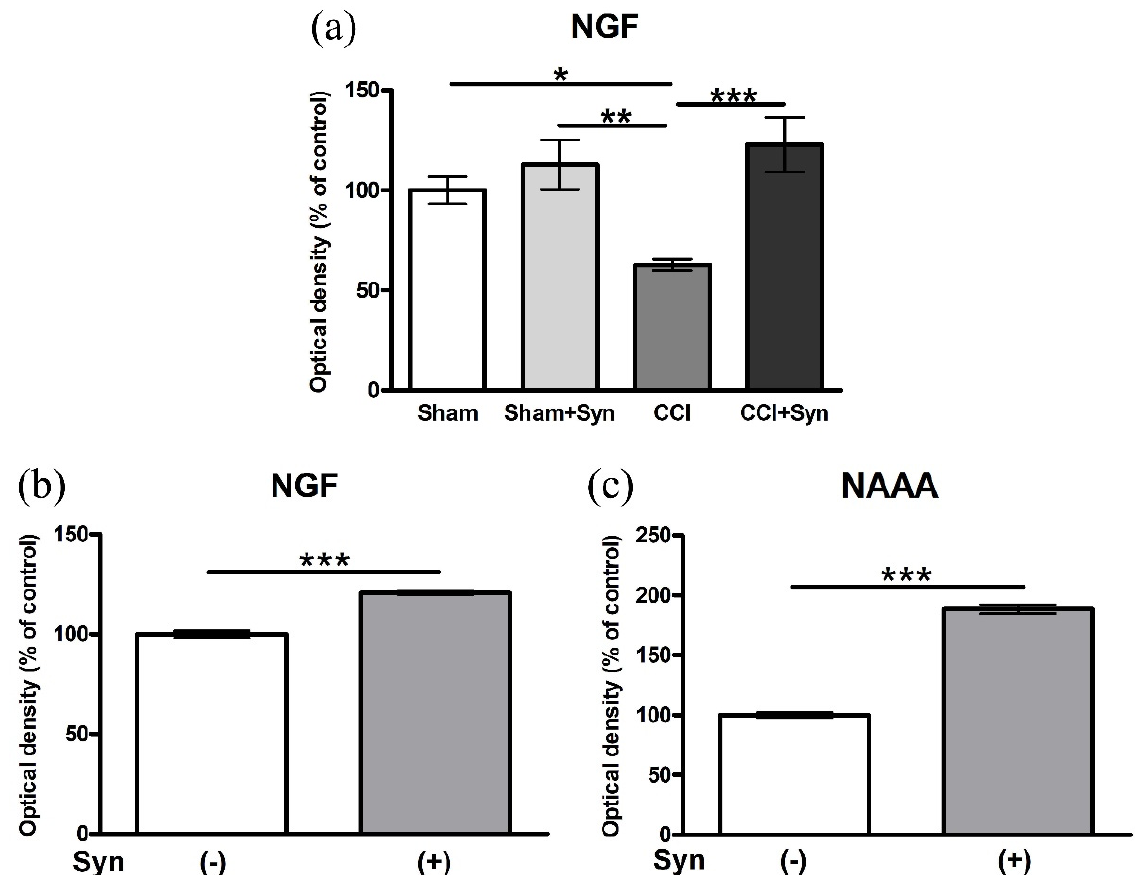
Figure 7. ( a ) Level of NGF expression in the hippocampus after CCI and synaptamide treatment. Data are presented as mean ± SEM, n = 7/group, * p < 0.05, ** p < 0.01, and *** p < 0.001 (one-way ANOVA, post-test Tukey). Level of ( b ) NGF and ( c ) NAAA expression in the astroglial cells treated with synaptamide (10 µ M). Data are presented as mean ± SEM, n = 9/number of analyzed samples, *** p < 0.001 (Mann–Whitney test).